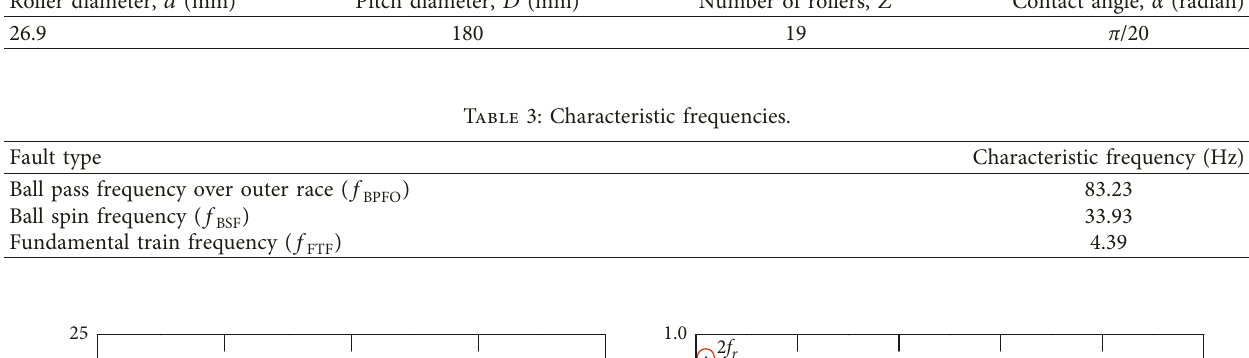
Table 2: Specifications of the tested bearing.